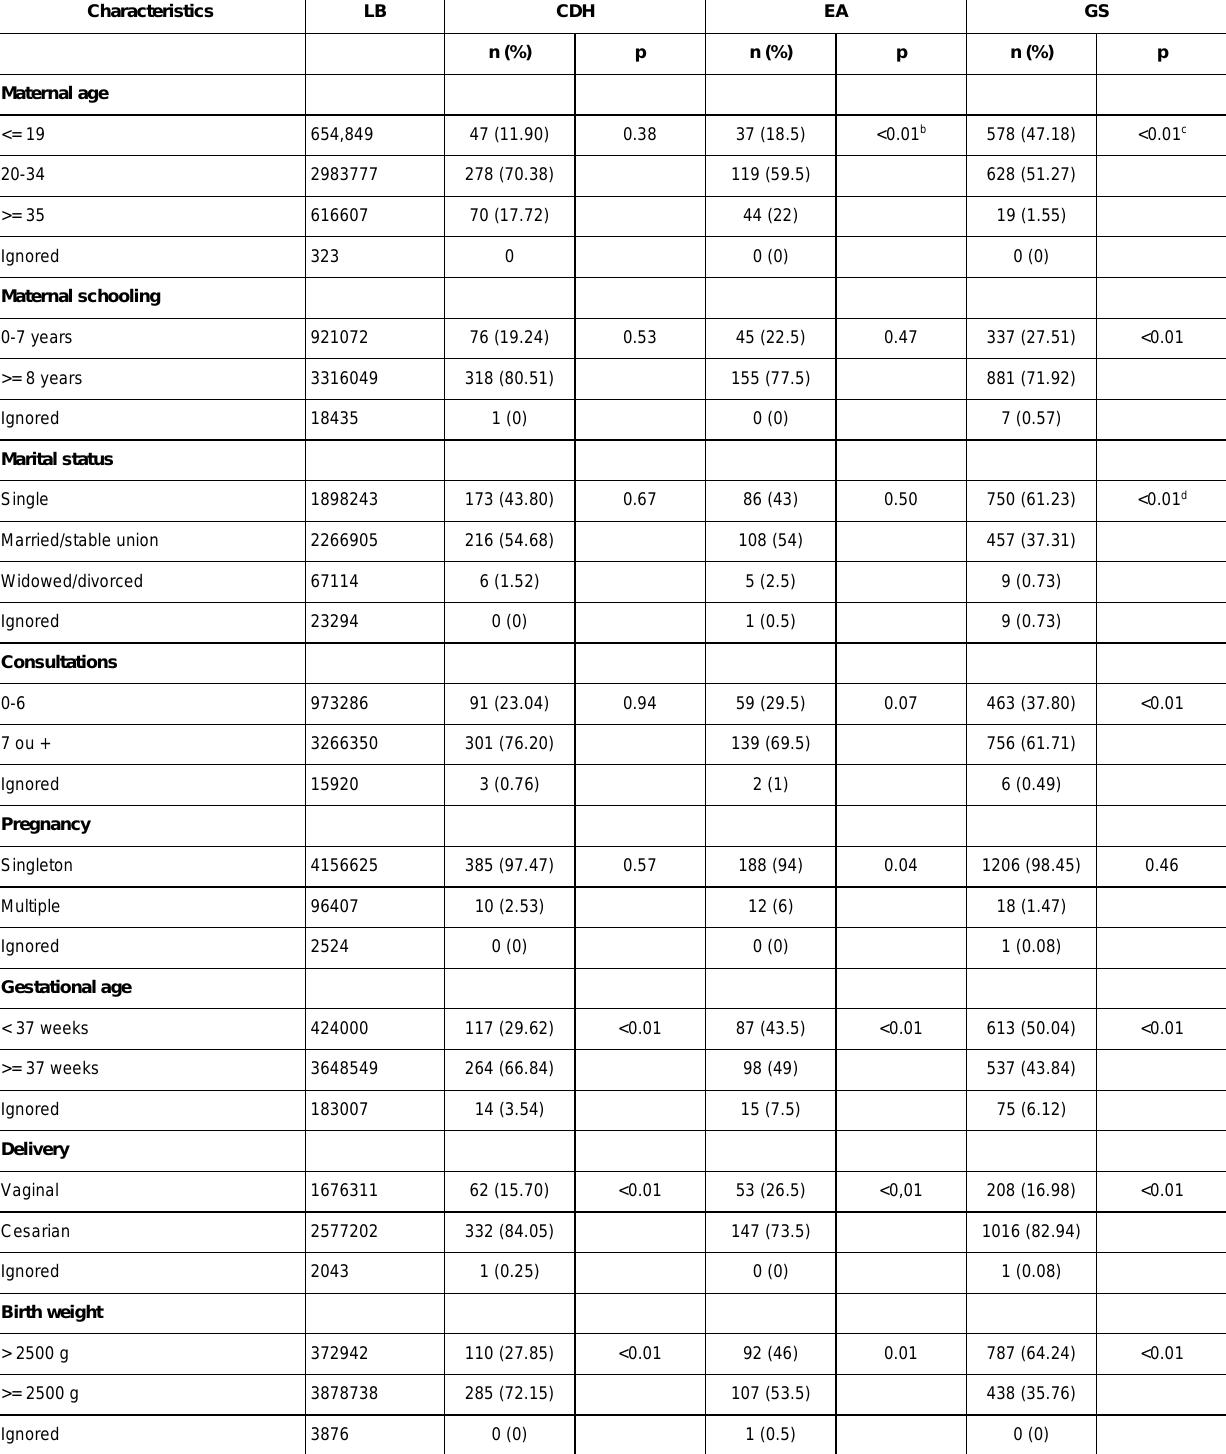
Table 2. Characteristics of Live Births (LB) with Congenital Diaphragmatic Hernia (CDH), Esophageal Atresia (EA), and Gastroschisis (GS) in South Brazil, 2009-2019